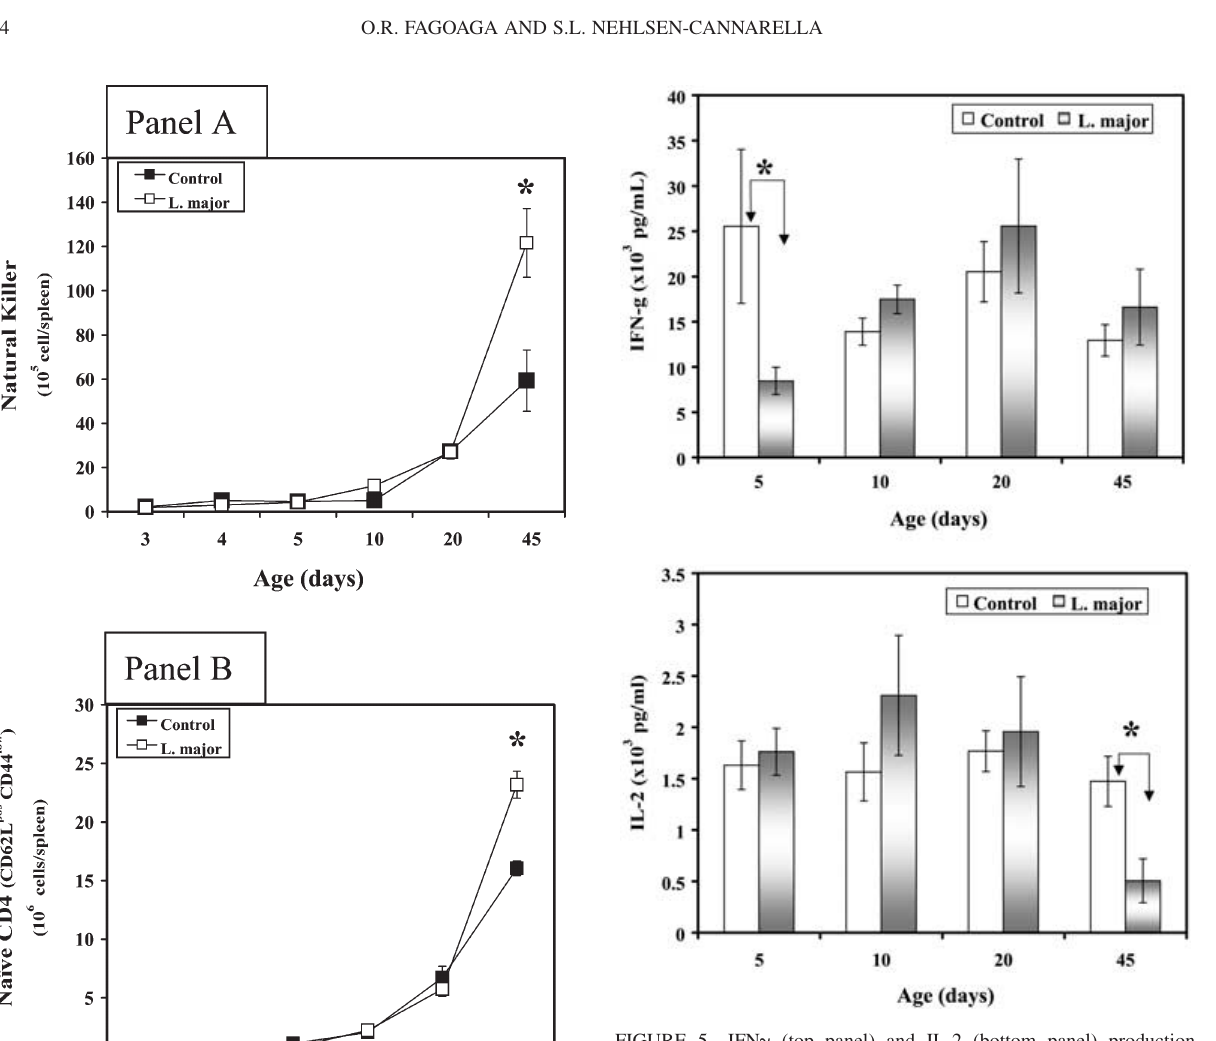
FIGURE 5 IFN g (top panel) and IL-2 (bottom panel) production (stimulated) by spleen cells of CD-1 outbred mice (male and female) delivered from dams treated during gestation with saline or L. major (175 m g/mouse i.p in saline). Each culture contained 1 £ 10 6 CD3 þ CD4 þ splenocytes and hamster anti-mouse CD3 monoclonal antibody in complete media. Control cells were cultured in media only. Data are expressed as mean ^ SE of samples (control: d5 ¼ 4 ; d10 ¼ 3 ; d20 ¼ 10 ; d45 ¼ 11 ; experimental: d5 ¼ 7 ; d10 ¼ 7 ; d20 ¼ 3 ; d45 ¼ 5 Þ : Samples in stimulated cultures were pools of randomized pups (d5 and 10, 10/pool; d20, 3/pool; d45, 1 pup). Statistical significance ( p , 0 : 05; df ¼ 3; F ¼ 3 : 6) between groups was derived from two-way ANOVA. Post hoc analyses with Student’s t -test (two-tail) revealed differences among groups per age (*, p , 0 : 05; df ¼ 9 (IFN g ) and 14 (IL-2); t statistic of 2 2.63 for IFN g and 2 2.45 for IL-2). See “Statistical analysis” section for further